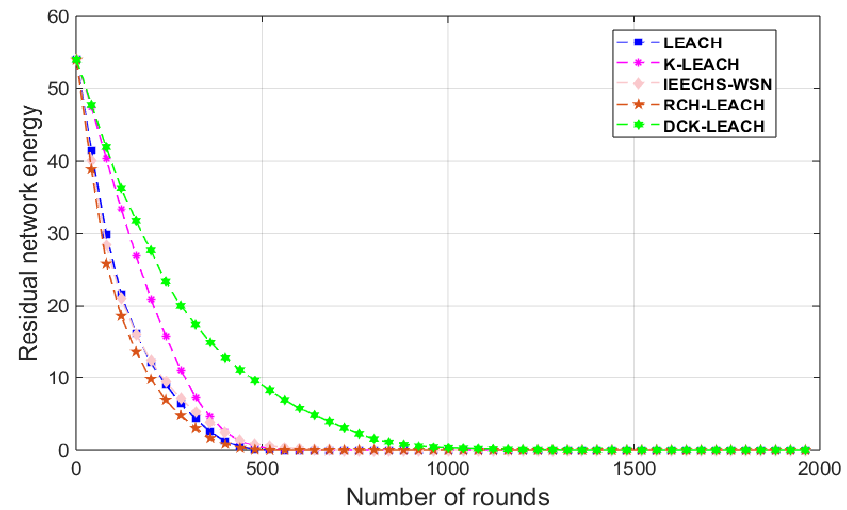
Figure 10. Comparison residual energy of the network.